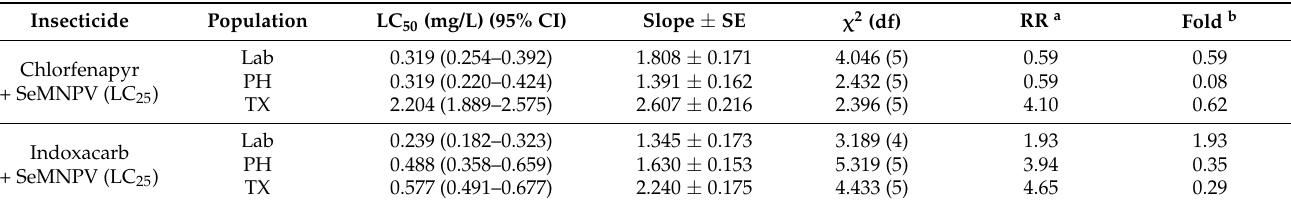
Indoxacarb + SeMNPV (LC 25 )